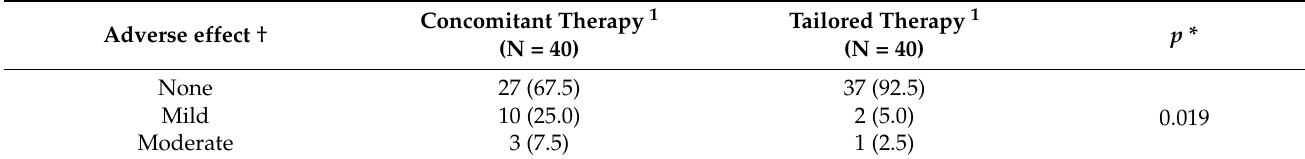
Table 5. Adverse effects severity